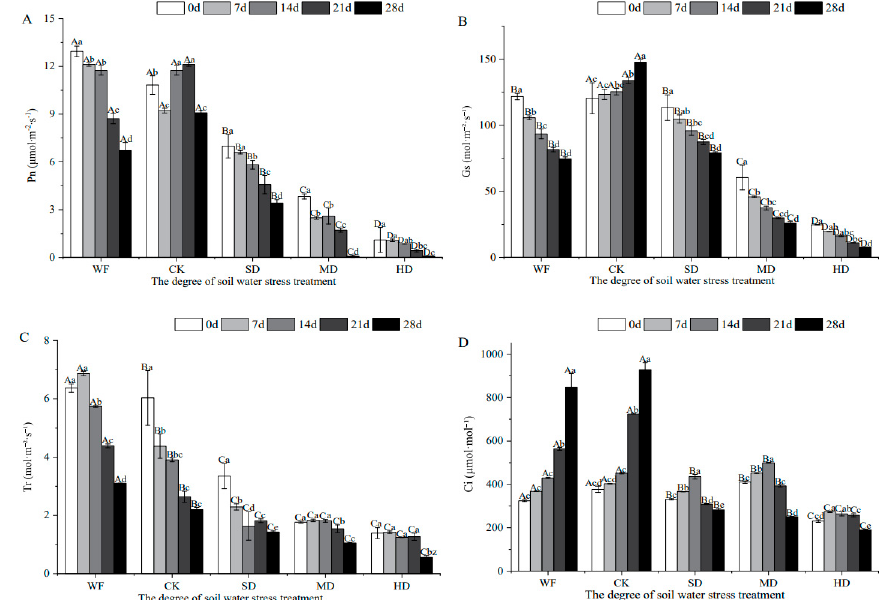
Figure 2. Effects of water stress on photosynthetic characteristics of C. retusus leaves. ( A ) Effects of water stress on Pn of C. retusus leaves; ( B ) Effects of water stress on Gs of C. retusus leaves; ( C ) Effects of water stress on Tr of C. retusus leaves; ( D ) Effects of water stress on Ci of C. retusus leaves. Upper- case letters represent the variations in different treatment groups, and lower-case letters represent the difference in stress days within the group (significant). See the caption for Figure 1 for an explanation of abbreviations.